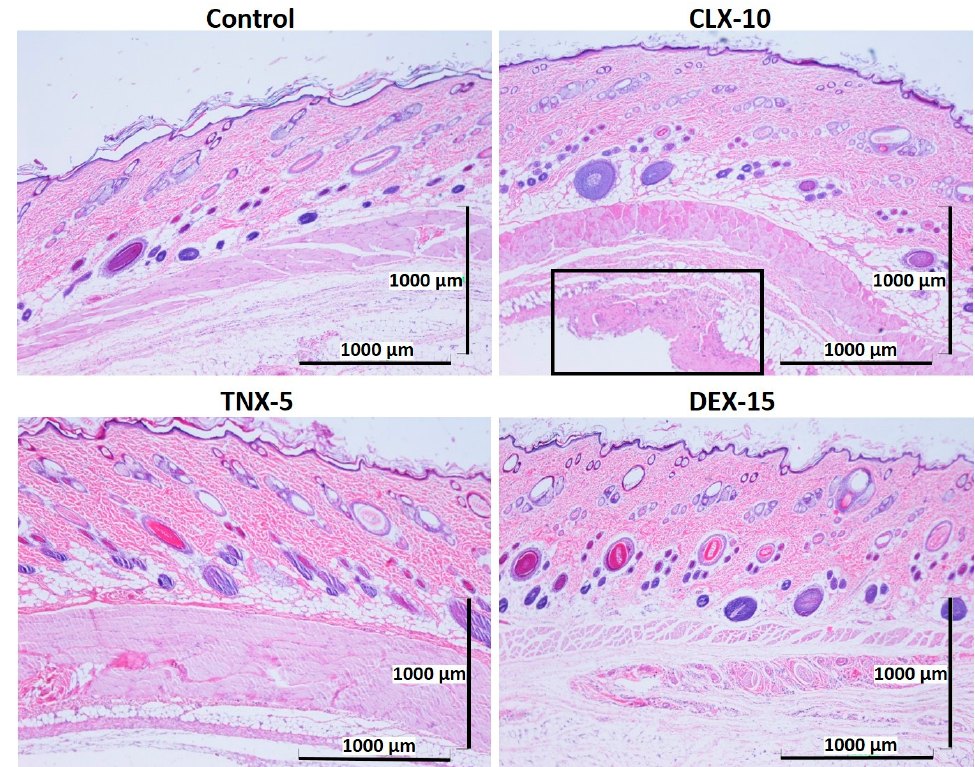
Figure 6. Representative histological photomicrographs of skin cross-sections of rats subcutaneously injected with CLX-10, TNX-5 and DEX-15 NPs compared to the control group after one week. In the image corresponding to CLX-10-treated rats, some tissue reaction (squared and amplified in Figure S5) was observed, mainly based on macrophage infiltration (H-E).